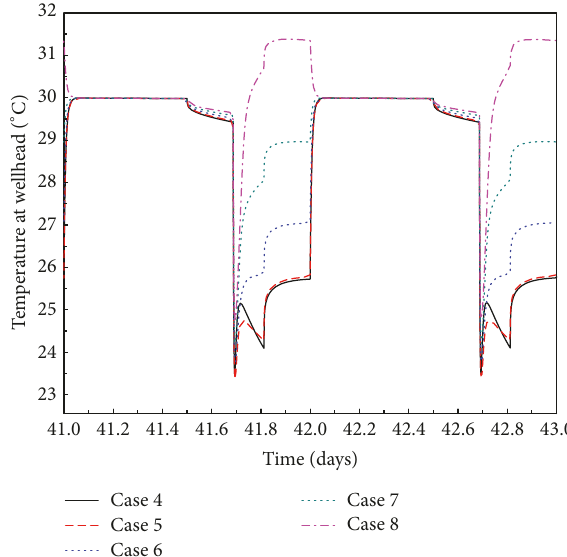
Figure 13: Comparison of the temperate changes at the wellhead during the operation cycle processes among the five depth